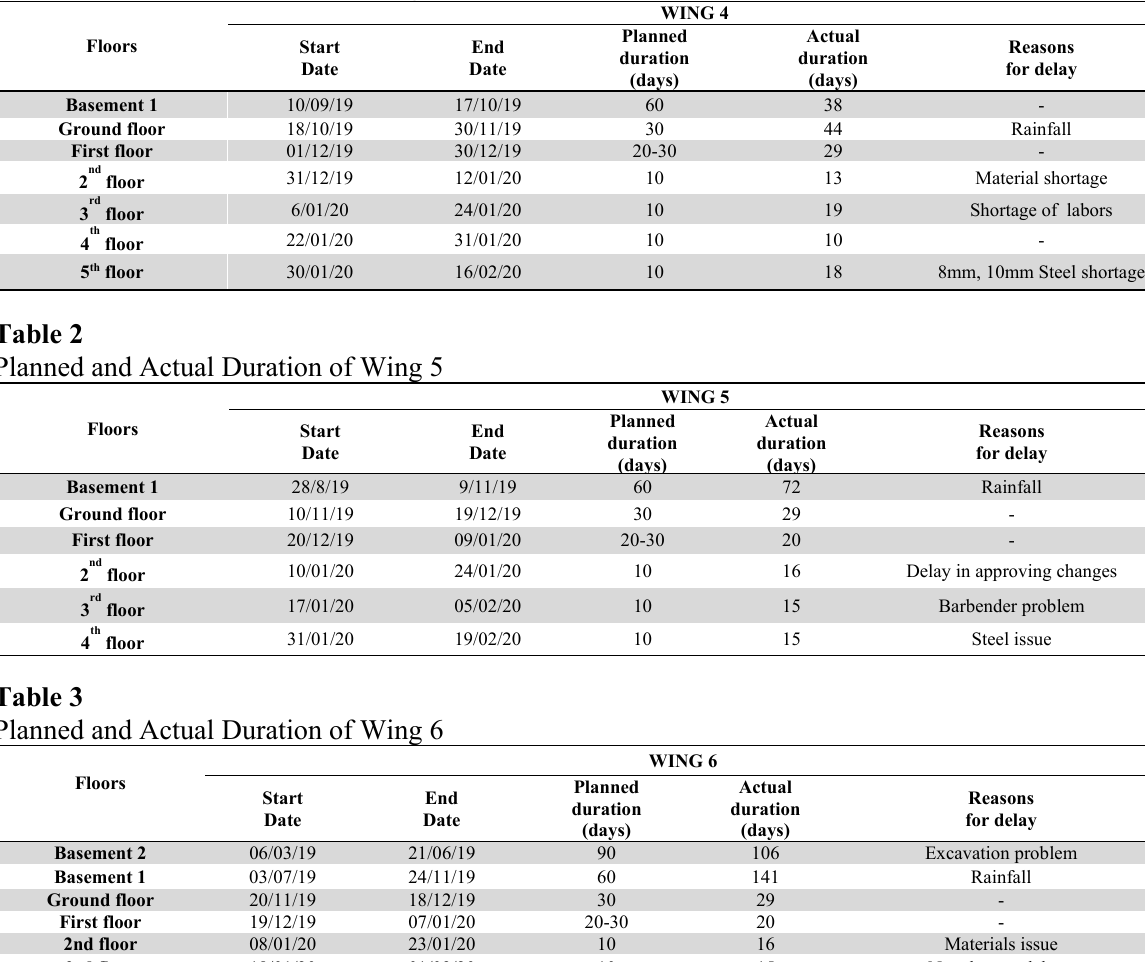
Planned and Actual Duration of Wing 4